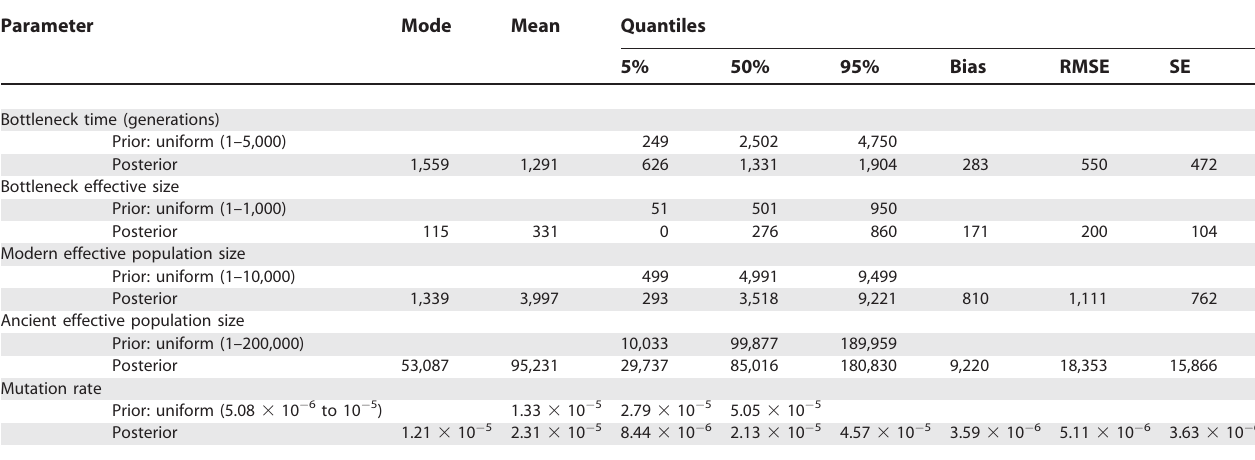
Table 1. Mode, Mean, and Quantile Values of the Prior and Posteriors for the Demographic and Marker Parameters of C. sociabilis Used in This Study